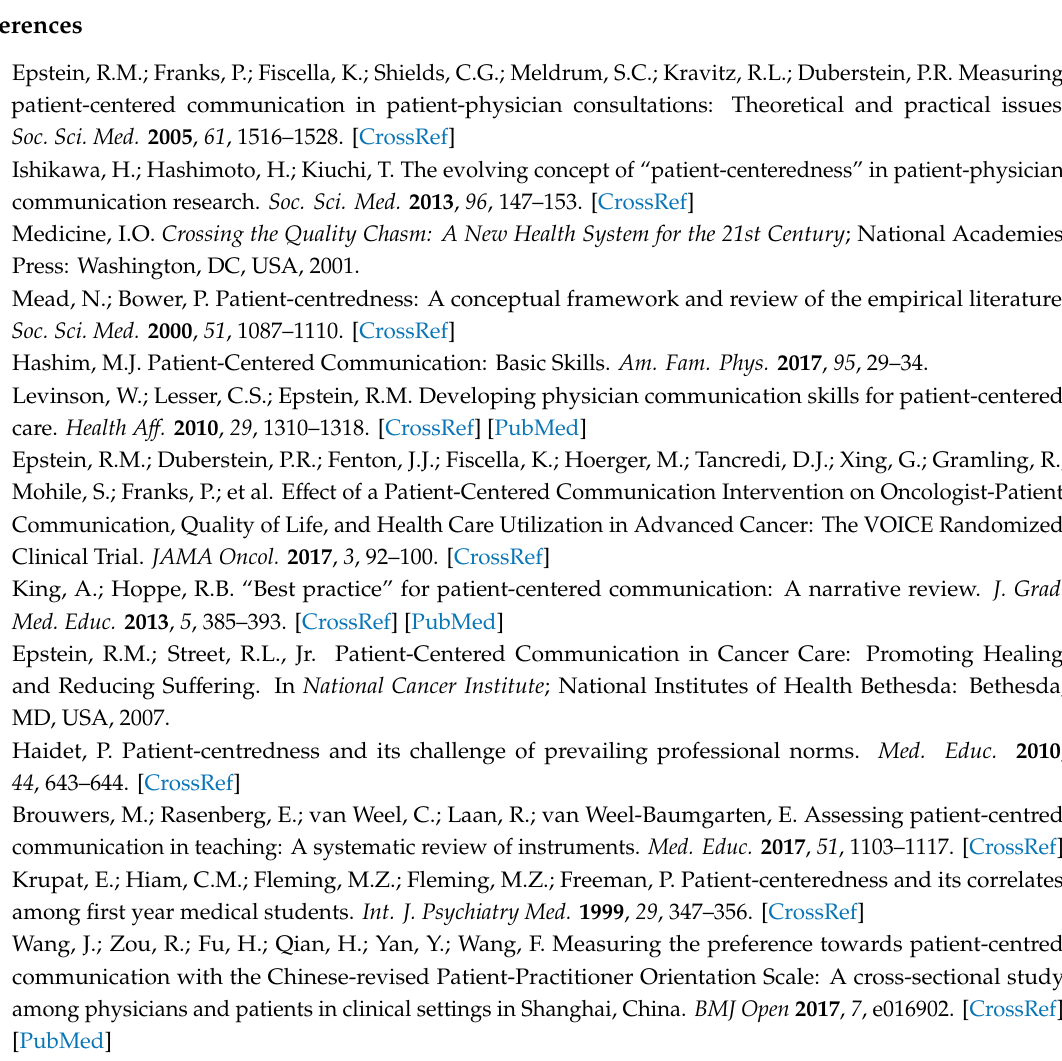
Figure S1: The geographic distribution of the participants in Hubei Province, China; Figure S2: The distribution of CR-PPOS scores split by male and female; Table S1: Chinese Revised Practitioner-Patient Orientation Scale (English Version); The data source was presented as Data